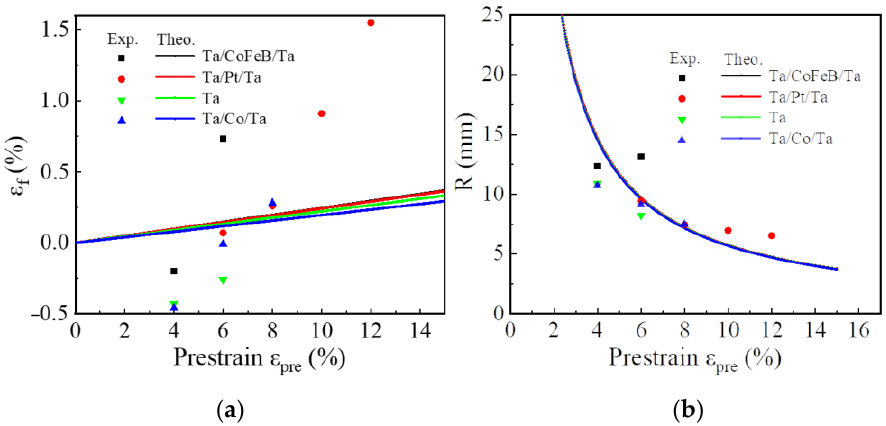
Figure 5. ( a ) Strain of different materials (25 nm thickness) on PDMS after releasing the prestrain as a function of the prestrain. ( b ) Radius of curvature of different materials (25 nm thickness) on PDMS as a function of the prestrain. The line is the theoretical value, and the point is the experimental value.